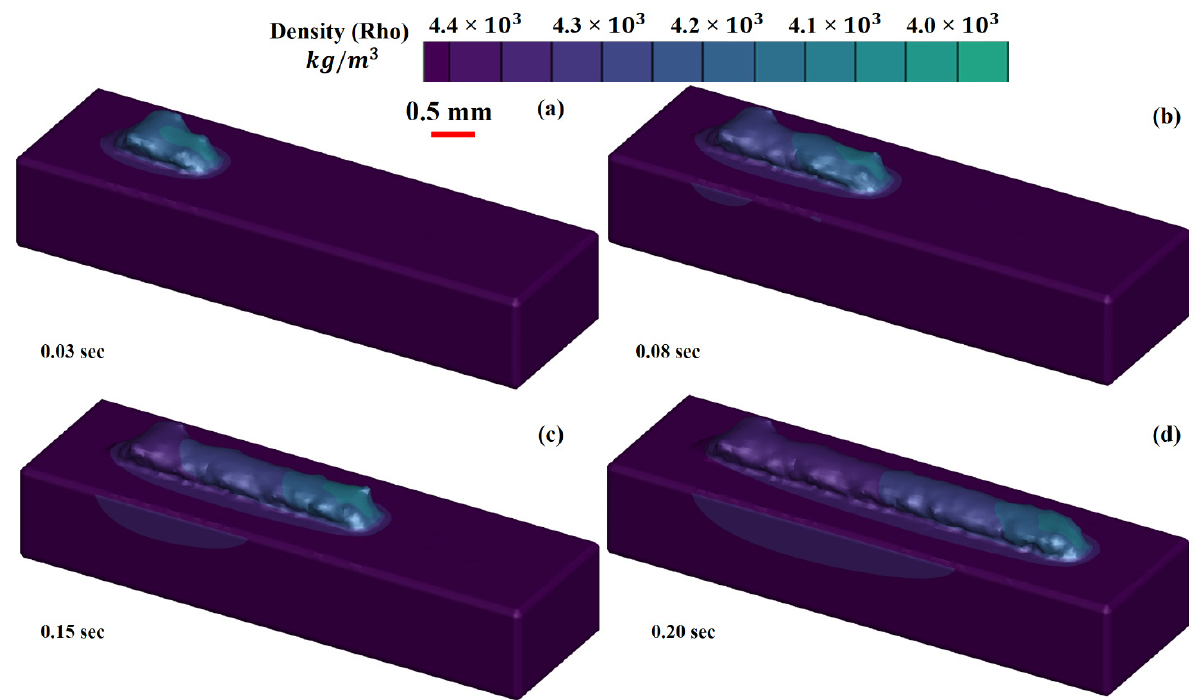
Figure 3. Three-dimensional view of the deposited layer with density evolution in the LMD deposition of Ti6Al4V at: ( a ) 0.03 s, ( b ) 0.08 s, ( c ) 0.15 s and ( d ) 0.20 s.